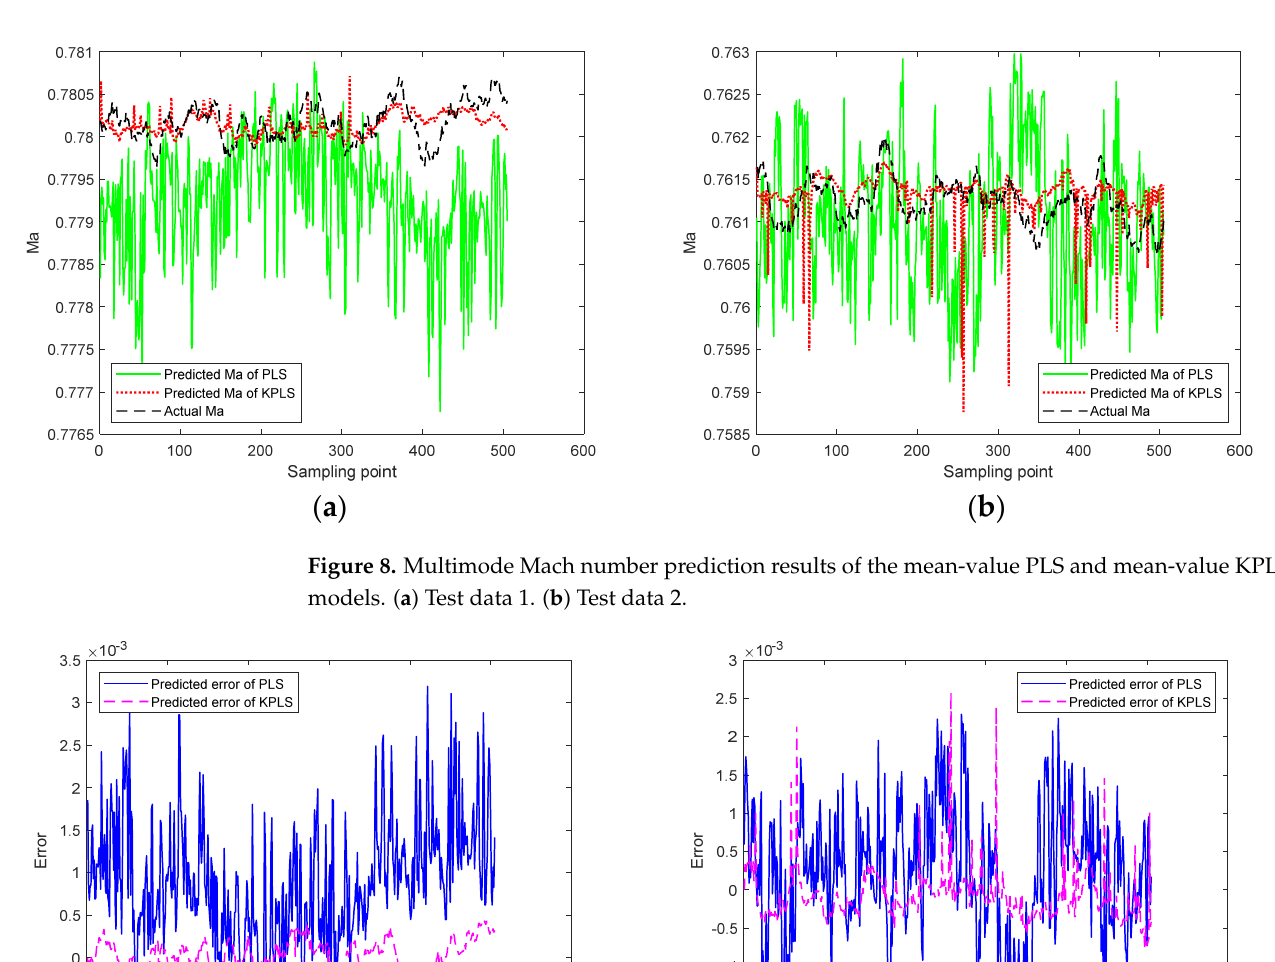
Table 3. RMSE values obtained using the mean-value PLS and mean-value KPLS models.